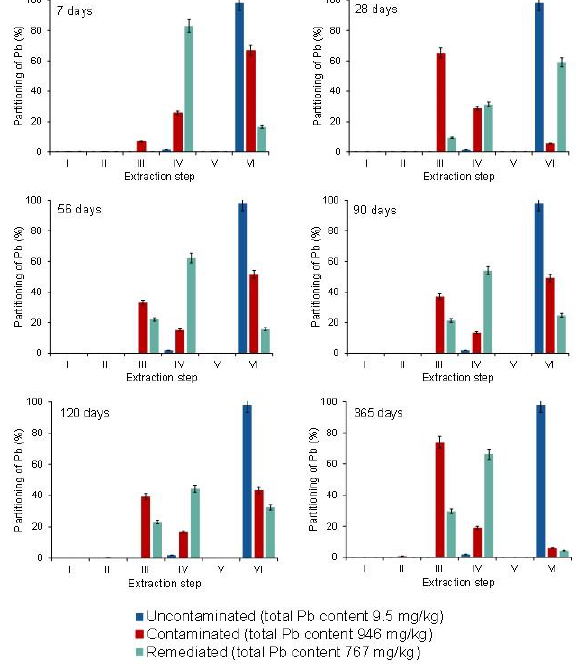
Figure 4. Partitioning of Pb in uncontaminated, contaminated, and remediated soil samples with time elapsed after the remediation. I water-soluble; II exchangeable; III bound to carbonates; IV bound to Fe/Mn oxides and hydroxides; V bound to organic matter; VI bound to silicate lattice.